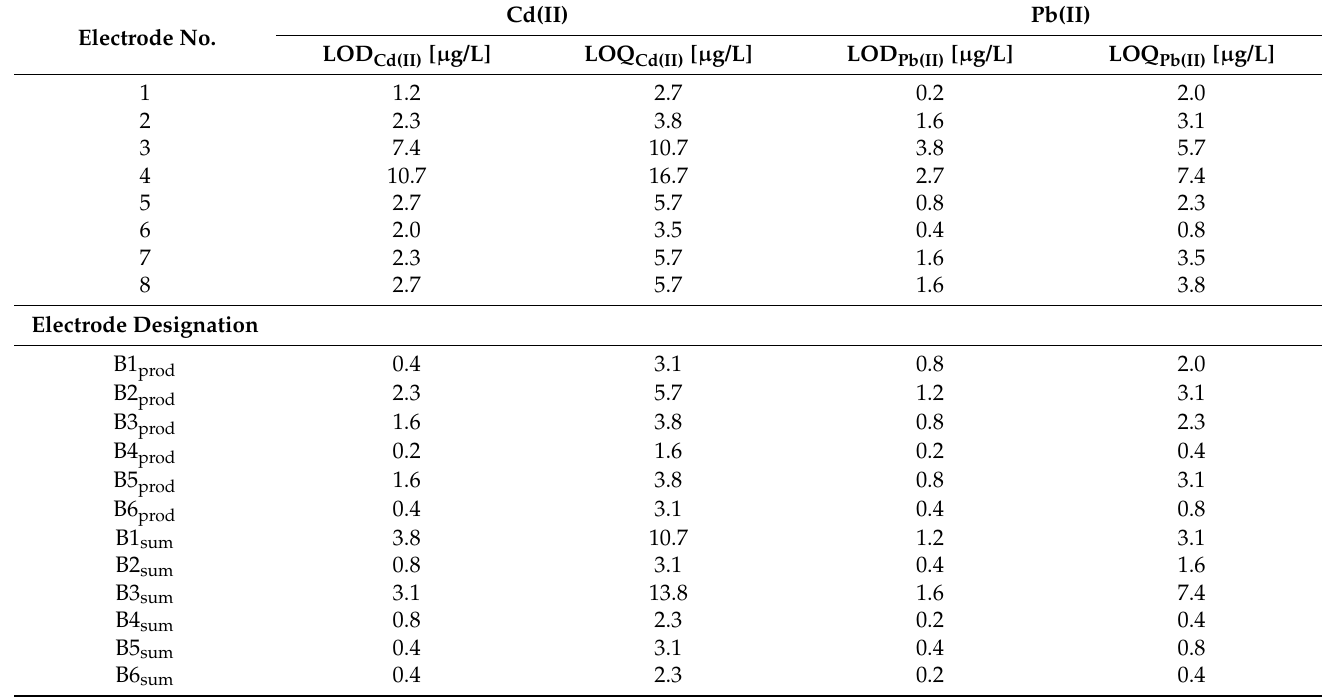
Table 6. The LOD and LOQ values determined during the course of the fractional factorial design testing and simplex optimization (with two different optimization criteria, i.e., OC prod and OC sum ). Electrode No.